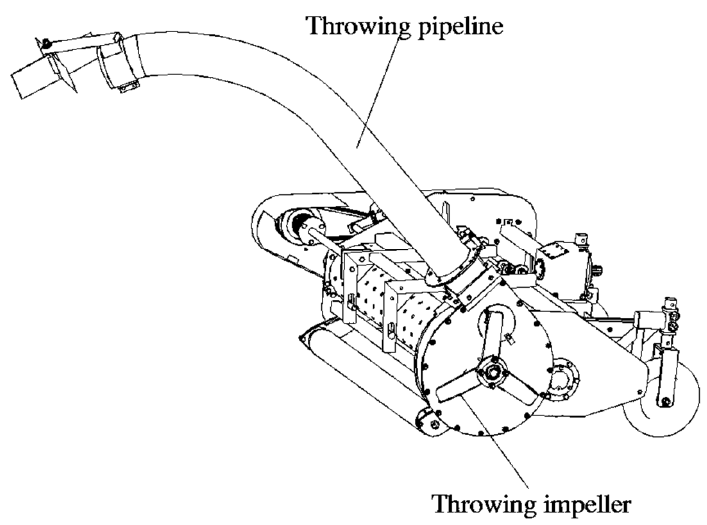
Figure 2. The structure of straw back-throwing device.